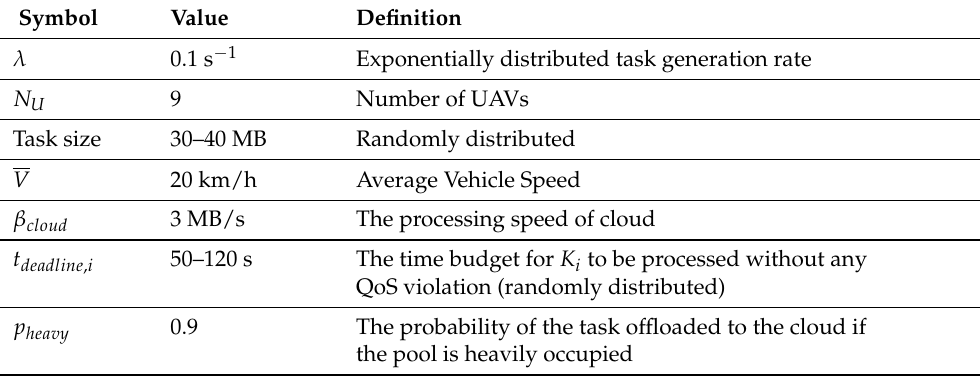
Table 4. Baseline simulation